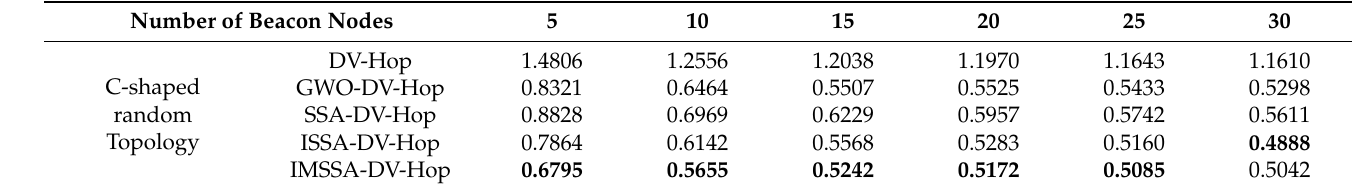
Table 7. Localization error in di ff erent number of anchor nodes in C-shaped random topology.